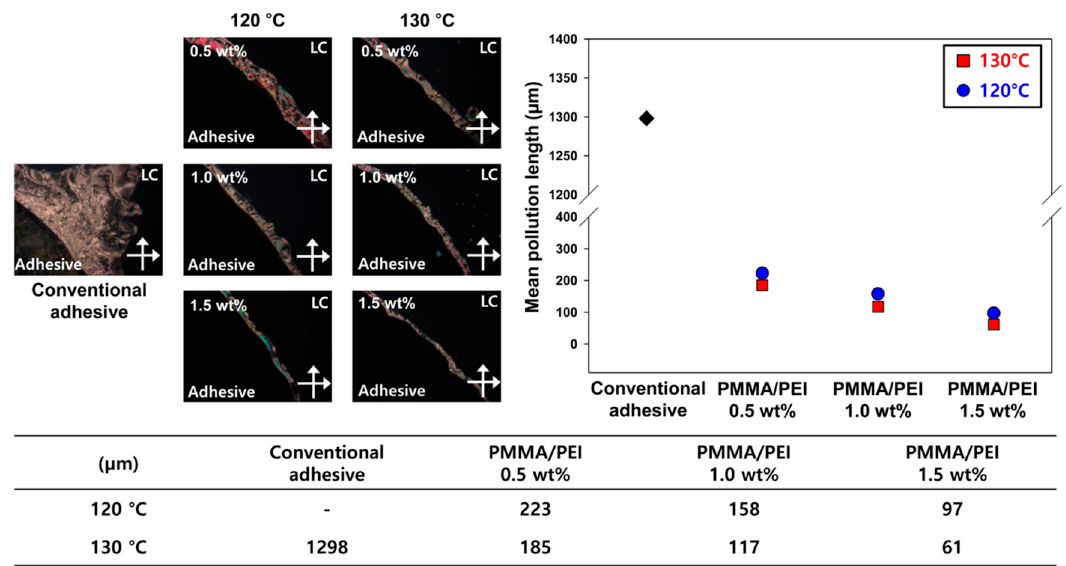
Figure 7. Mean pollution lengths of conventional and new adhesives after heat treatment at 120 or 130 ° C.